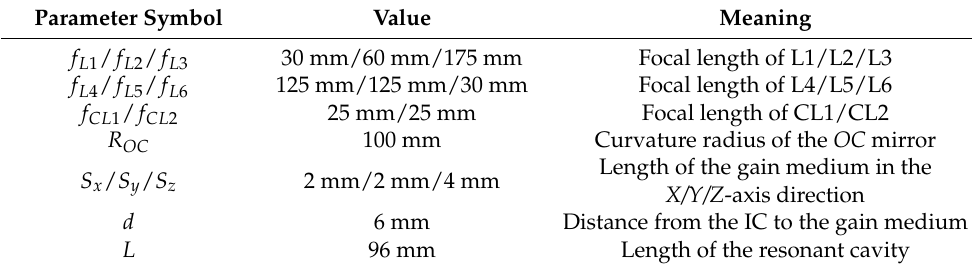
Figure 2. ( a ) Classic Z-shaped cavity; ( b ) the equivalent straight cavity after the cavity expansion process.